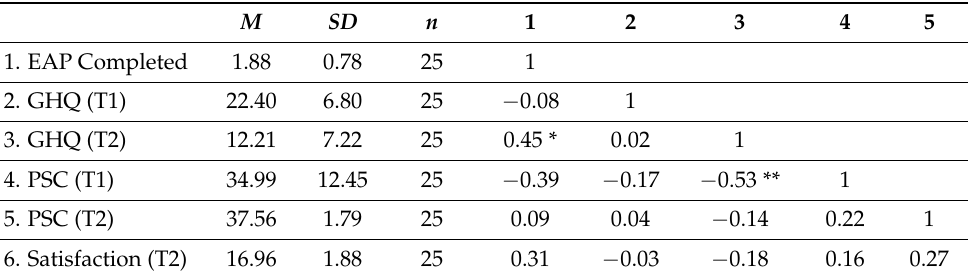
Table 1. Descriptive Statistics; Means, Standard Deviations and Correlations.